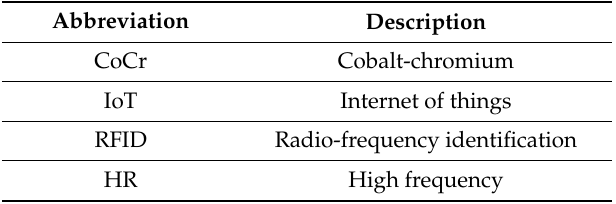
Table 1. Summary of